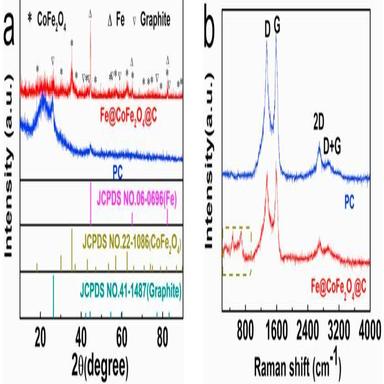
XRD patterns (a) and Raman spectra (b) of Fe@CoFe2O4@C and PC.